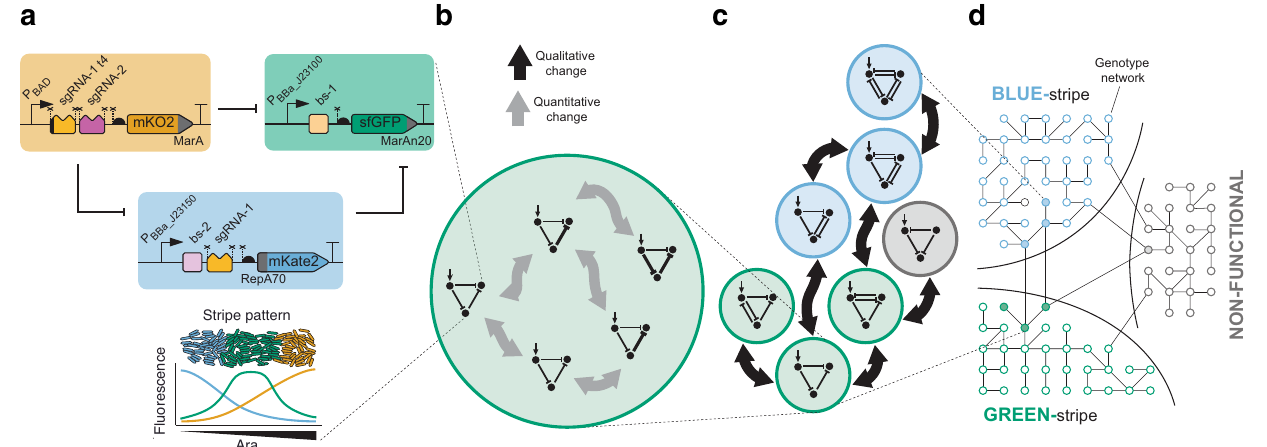
b For a GRN topology, there might exist multiple interlinked GRN variants with different parameters thatpreserve the same phenotype (hereshown